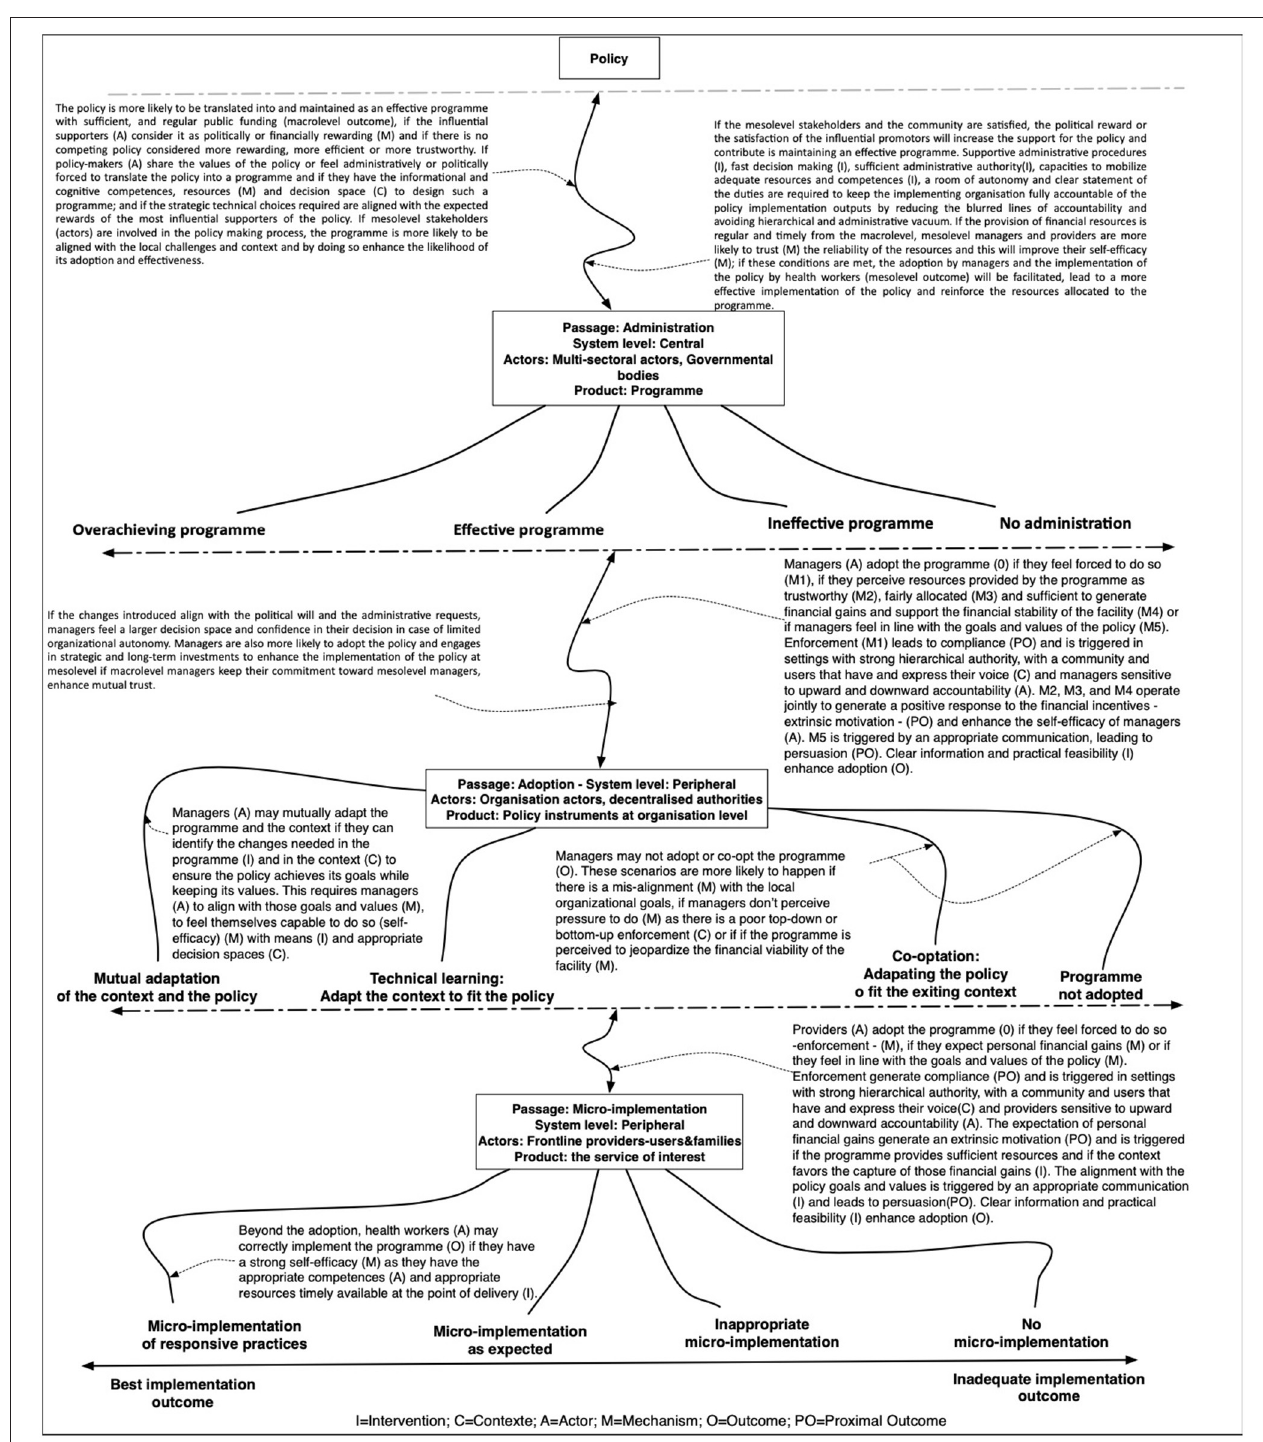
FIGURE 4 | The refined programme theory.